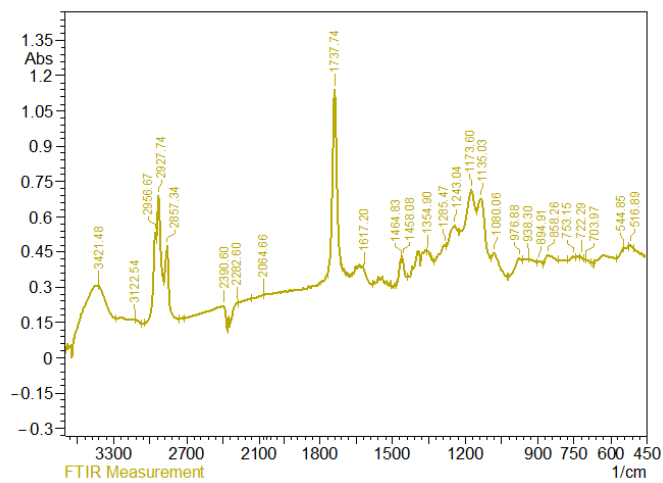
Figure 1. FTIR spectra of butyl butoxyethyl adipate.